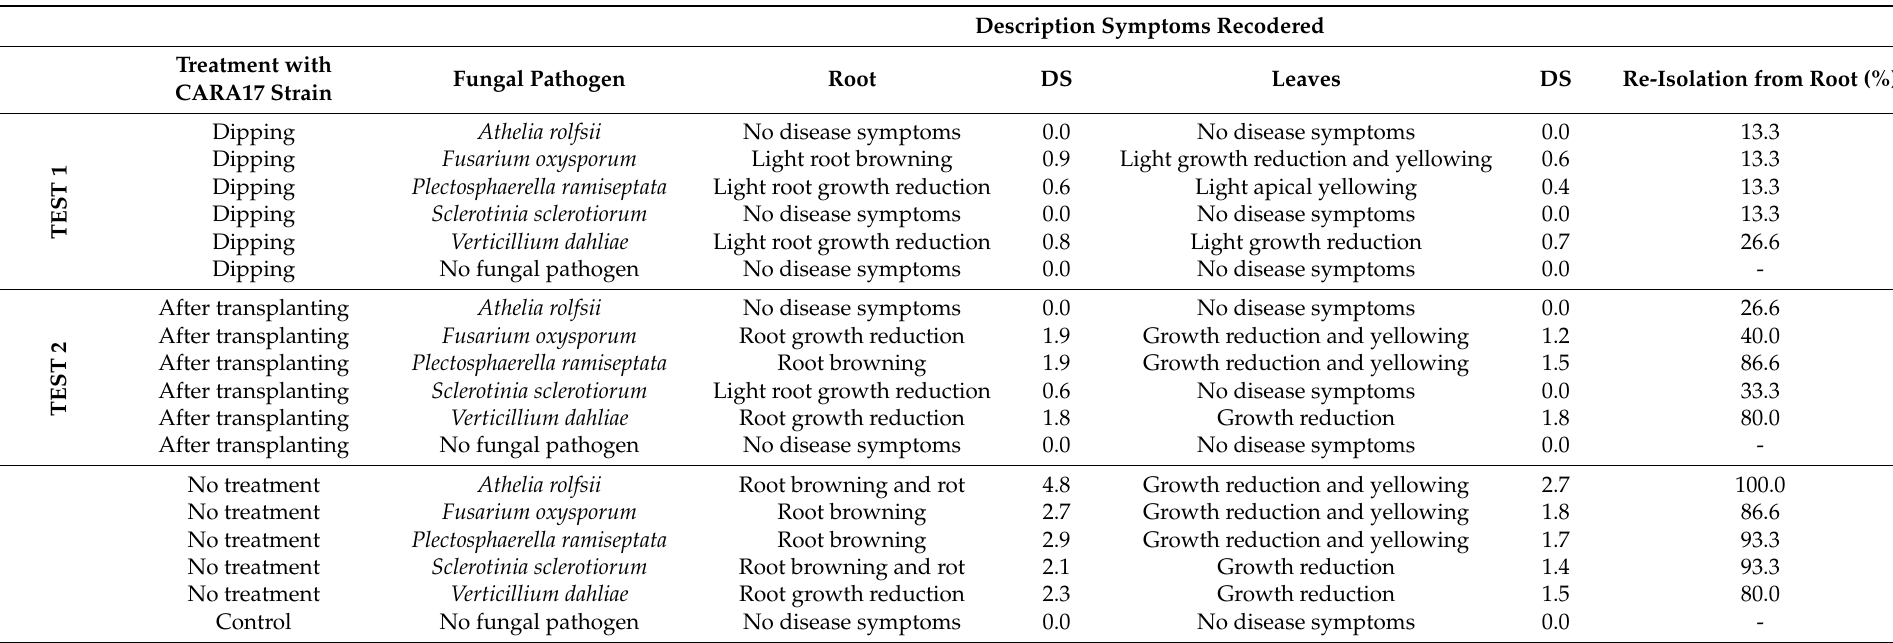
Table 2. Effectiveness of CARA17 strain as antagonist for controlling disease severity (DS) against fungal soil-borne pathogens on fennel seedlings. Description Symptoms